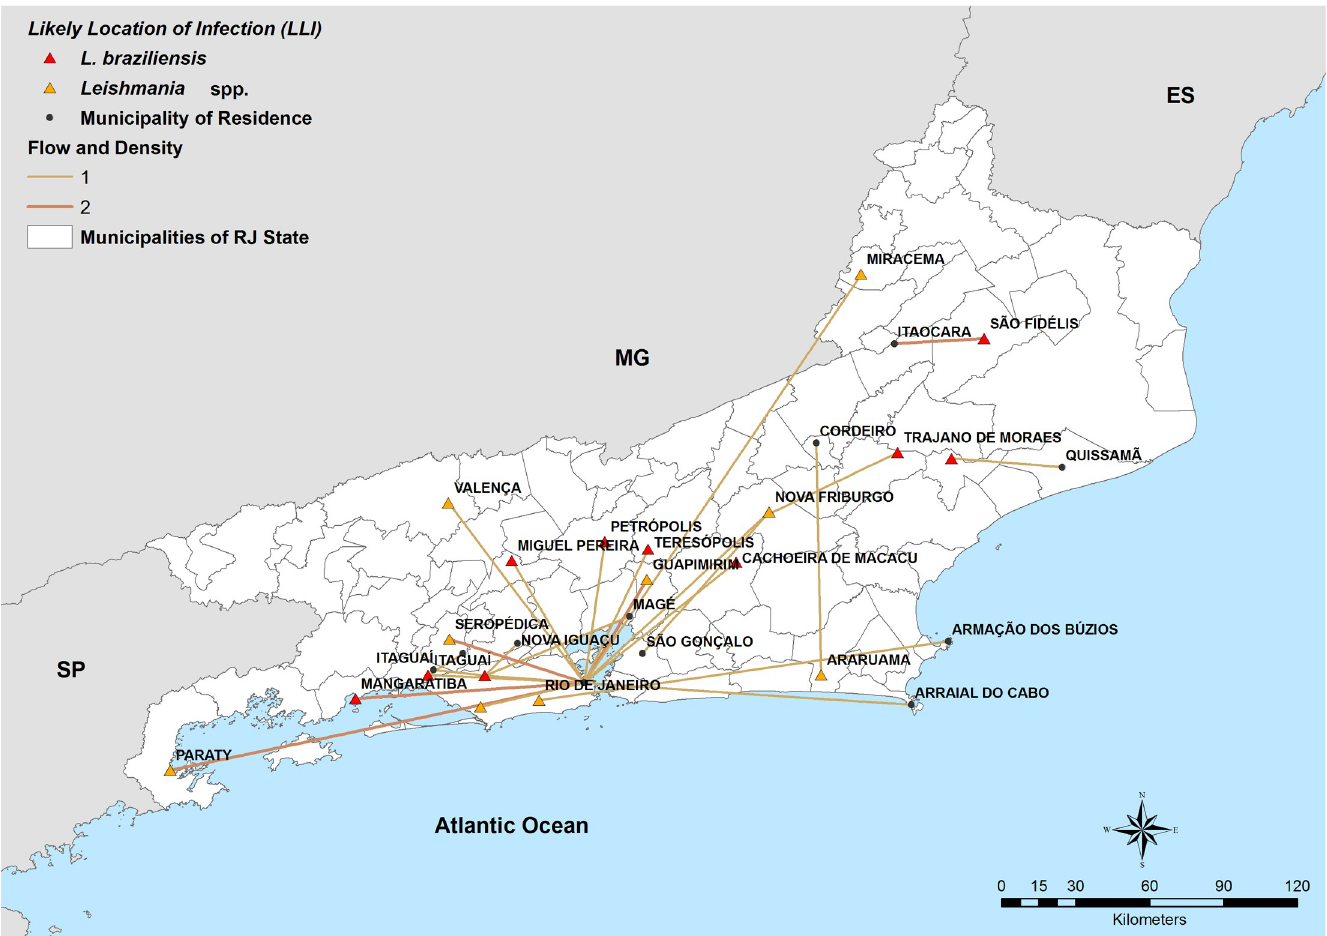
Fig 5. Flow map with density of cases in Rio de Janeiro state. Municipalities of residence are represented by circles and likely location of infection by triangles. Unidentified species ( Leishmania spp.) are represented by an orange triangle and species identified as L . (V . ) braziliensis by a red triangle. Yellow lines represent the migratory flow of one case (density 1) and brown lines represent the migratory flow of two cases (density 2). This map was created using ArcGIS 9.1 software and cartographic bases obtained from the Brazilian Institute of Geography and Statistics (https://ibge.gov.br/).